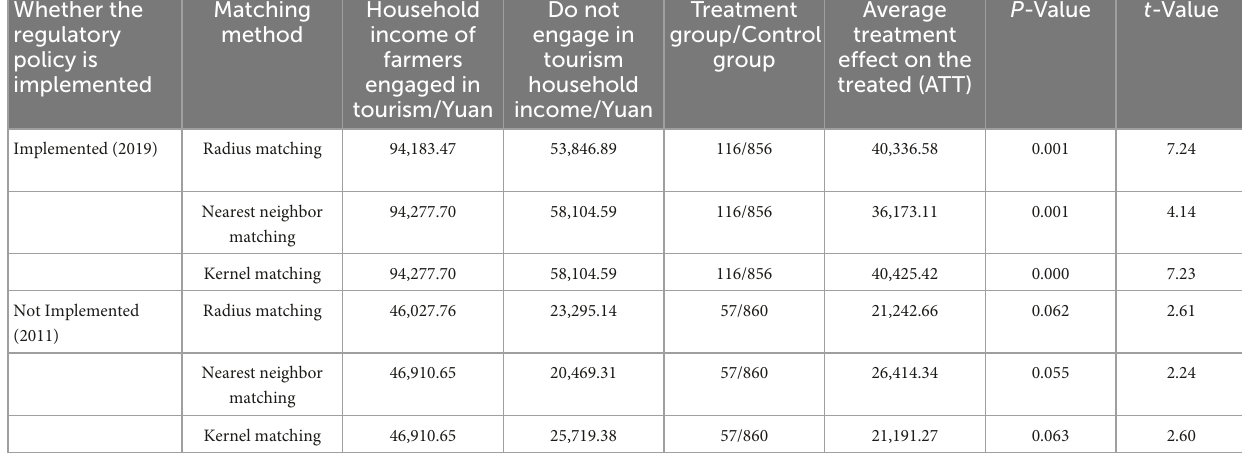
TABLE 3 The treatment effect of tourism on farmers’ income under the vertical implementation of the control policies.